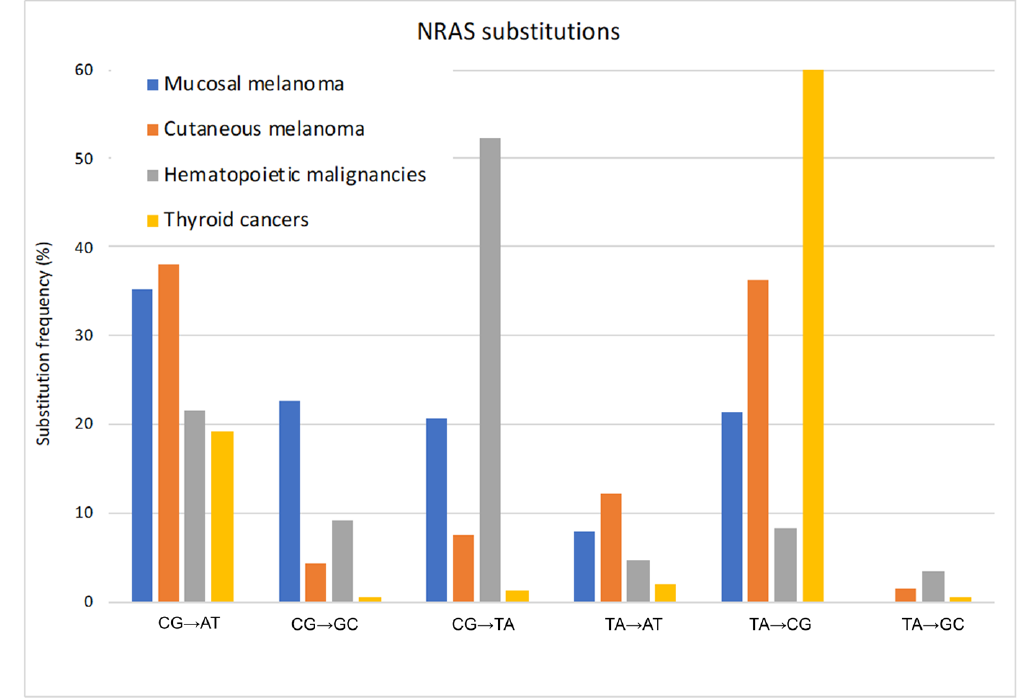
Figure 3. Proportion of somatic base changes in